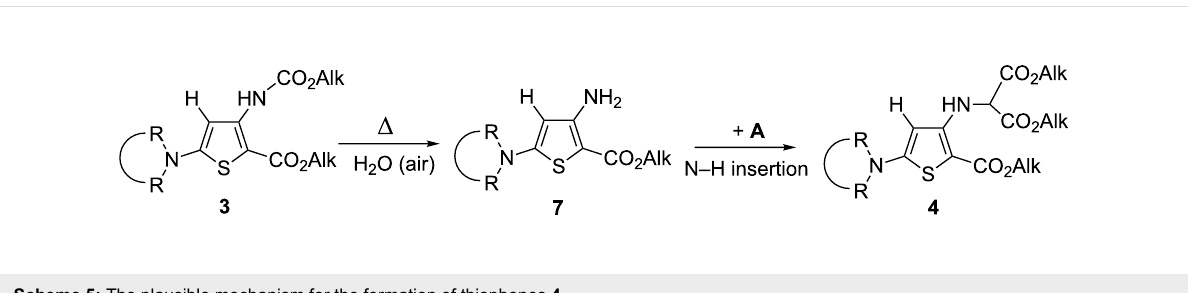
Scheme 5: The plausible mechanism for the formation of thiophenes 4 .